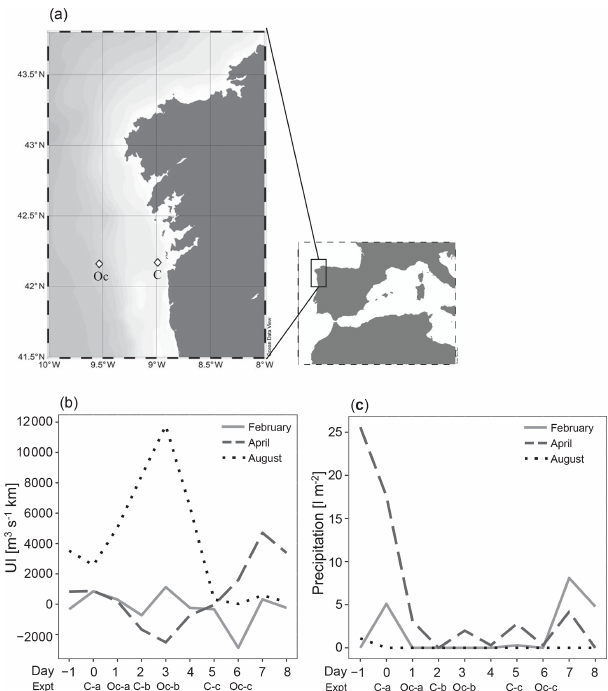
Figure 1. (a) The NW Iberian margin (rectangle) and locations of the stations that were sampled in the Ría de Vigo (C) and on the shelf (Oc) (diamonds), (b) distribution of daily coastal upwelling index (UI), and (c) registered precipitations during each sampling period showing the initial time of each experiment (C-a, C-b and C-c as well as Oc-a, Oc-b and